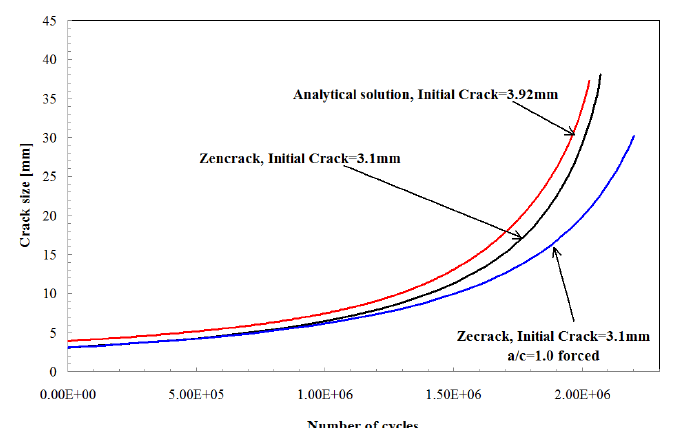
Figure 11: Comparison of analytical and numerical residual life (target=2.0x10 6